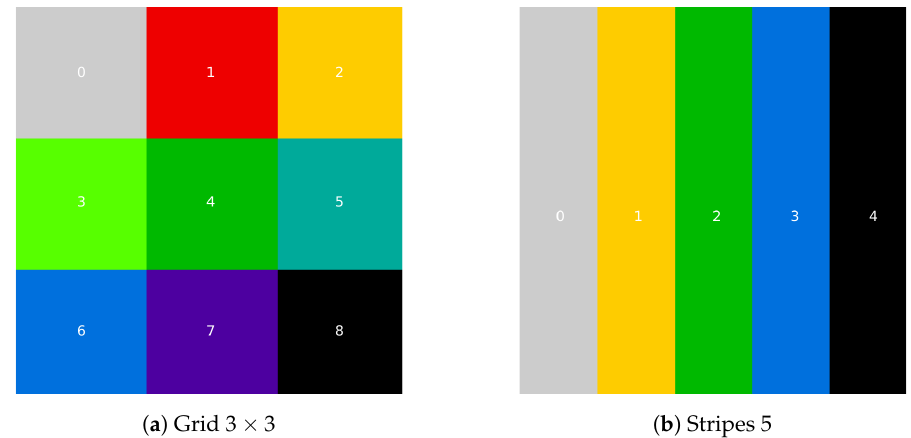
Figure 2. Example scheme of creating artificial classes on Indian Pines dataset. From left: grid of 9 artificial classes ( a ), vertical stripes with 5 artificial classes ( b ). Artificial classes for Pavia University dataset were created